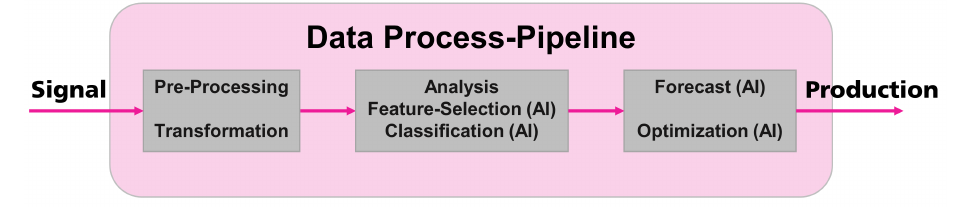
Figure 4. Data process